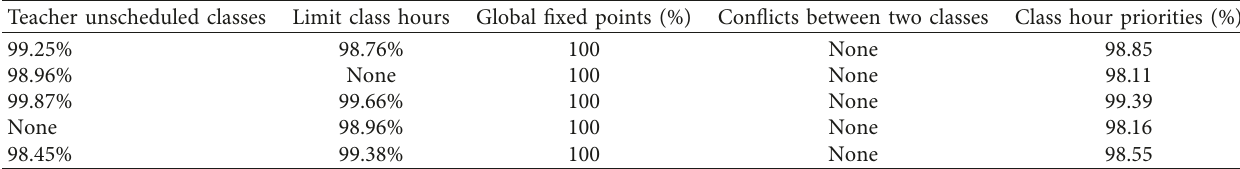
Table 4: Summary of the satisfaction rate of scheduling settable rules.